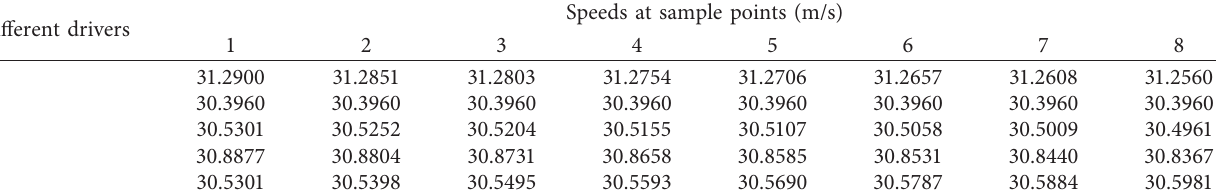
Table 1: Segments of the vehicle speeds.